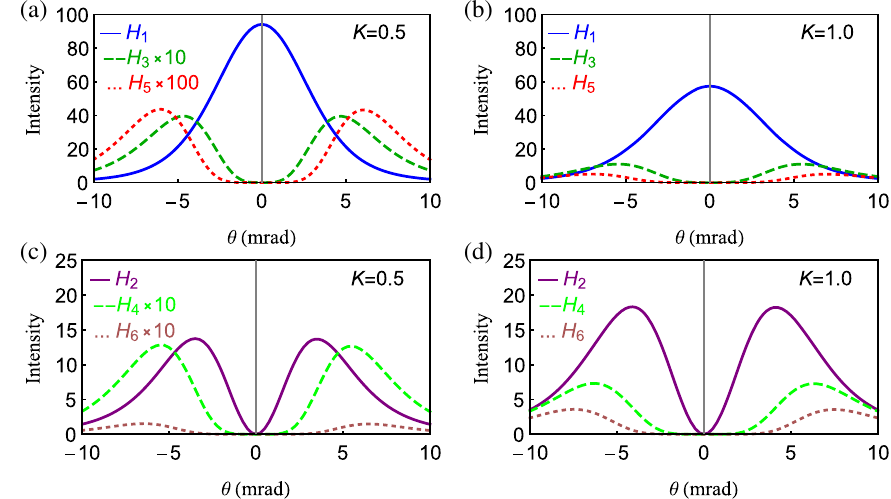
FIG. 6. Circular polarization: For a single electron the intensity (in units of 10 − 12 W m 2 = λ 4 u ) at a distance of 100 λ u of the first three odd and even harmonics versus the off-axis angle θ in a far-field transverse plane. The electron energy is 60 MeV.